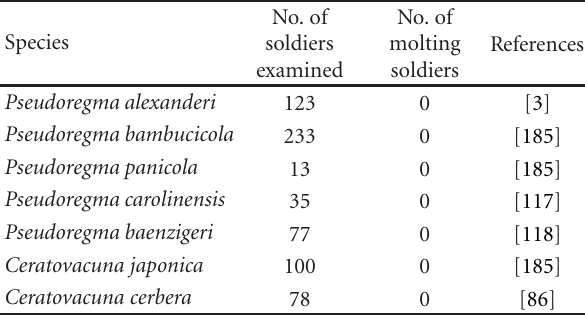
Table 5: Molting rate of cerataphidine soldiers on the secondary